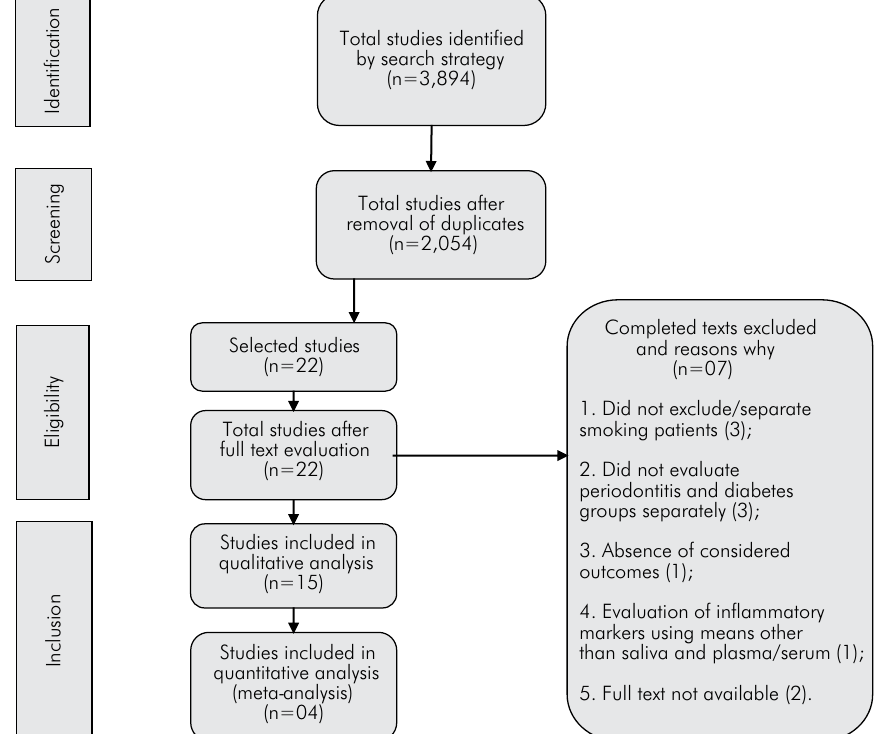
Figure 1. Flow diagram of the search and selection process of the studies (adapted from